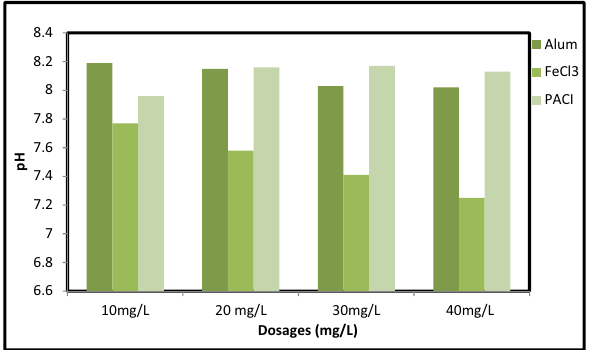
Figure 3: The relation between pH and dosage of coagulants for samples taken at a height of 60